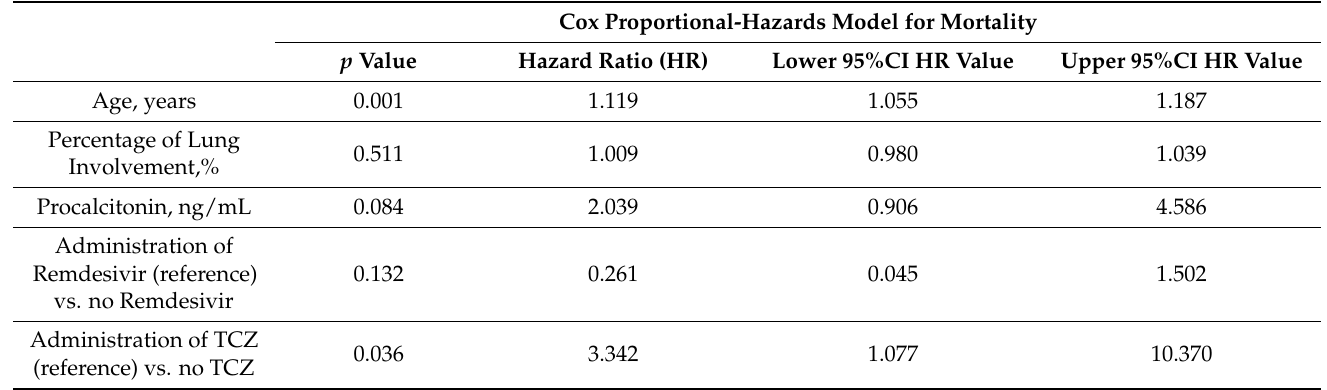
Table 4. Cox proportional-hazards model for mortality